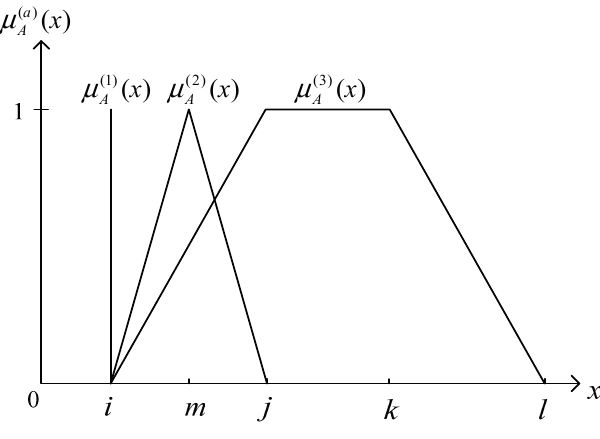
Figure 3. Different types of membership